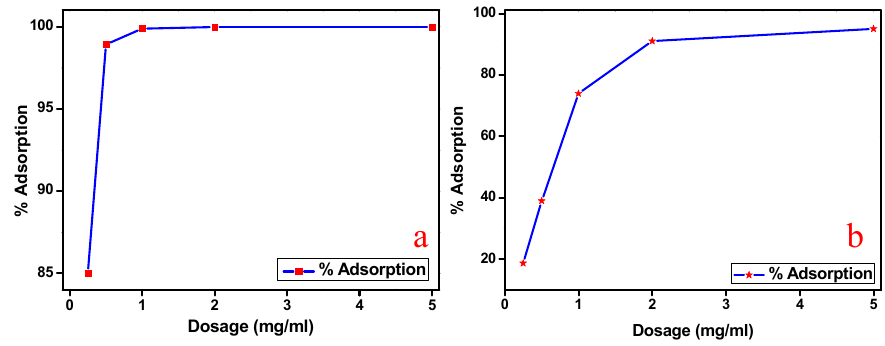
Figure 7. Effect of adsorbent dosage on percentage removal of ( a ) MB and ( b ) MO in the presence of GOPSr-2 (initial MB and MO concentration: 20 mg·L − 1 ; pH 7; time: 30 min at room temperature).